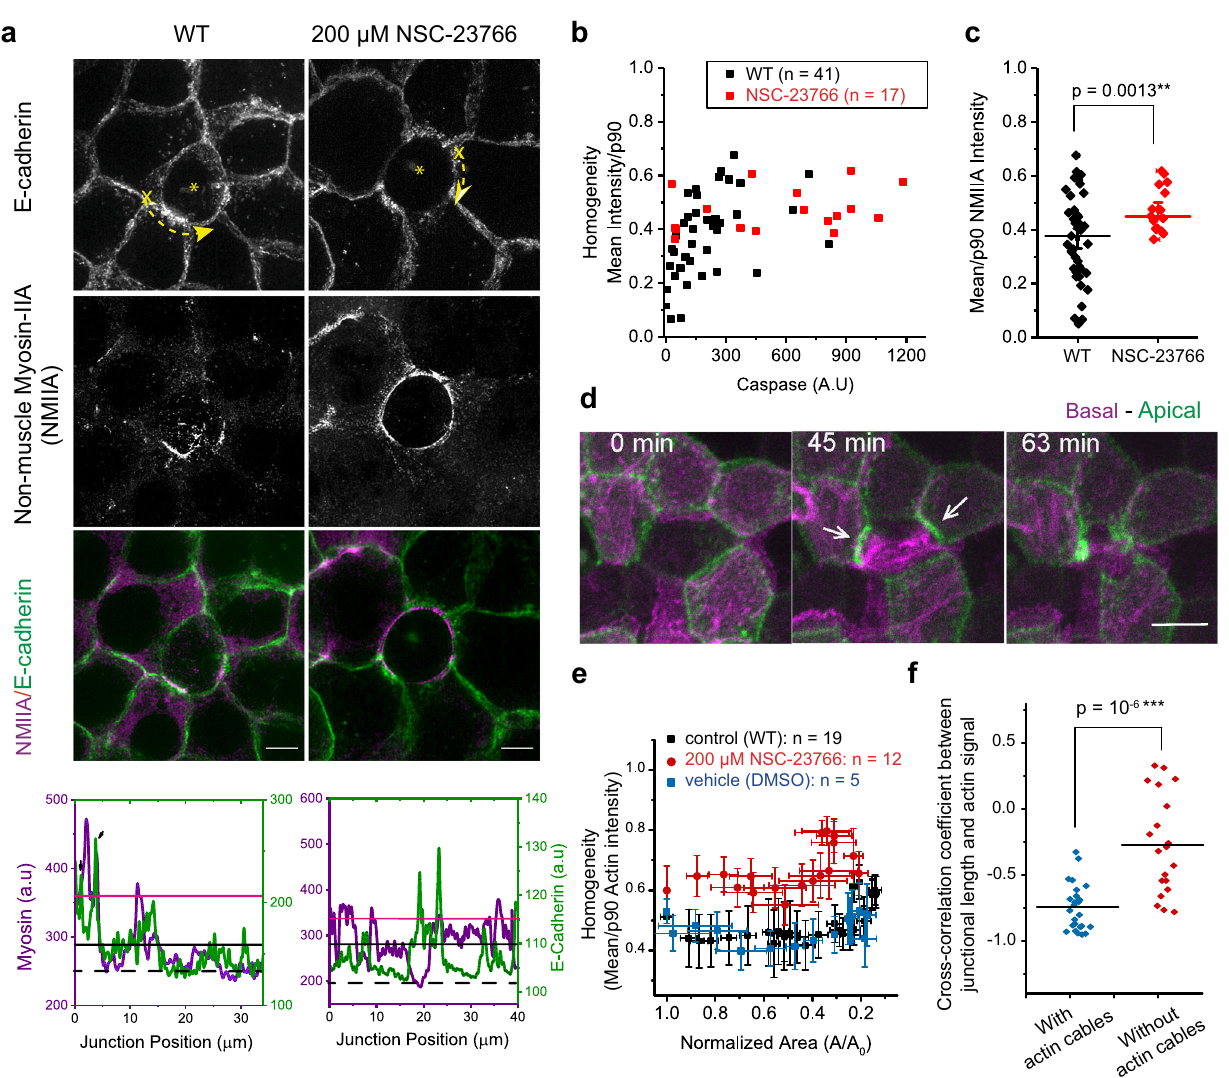
Fig. 2 Inhomogeneous actomyosin cables were observed and persistent during extrusion. a Immunostaining of non-muscle myosin-IIA (NMIIA) of extruding cells (asterisks) in MDCK stably expressing GFP-E-cadherin (WT) monolayer versus Rac-inhibited monolayer. Images show maximal projection of z-stack from 2 – 6 µ m above basal plane of SIM images. Scale bar = 10 µ m. Bottom panel: line scan of 10-pixel width showing intensity pro fi le along the junction between neighboring cells-extruding cell. Position 0 is indicated by X in the fi rst panel. Dashed arrows indicate the direction the line scan was performed. b Relationship between NMIIA intensity inhomogeneity and fl uorescence of caspase indicator. (Number of extrusion events: n = 41 for WT and n = 17 for Rac-inhibitor treatment. Number of independent experiments: m = 4 for WT and m = 2 for Rac-inhibitor treatment). Values closer to 1 indicate more homogeneous cables and closer to 0 indicates more nonuniform cables. c Inhomogeneity of actomyosin cables between WT versus Rac-inhibited monolayers by mean/p90 (normalized against the background intensity). Middle lines: mean. Error bars: SEM. Two-tailed unpaired t -test was performed. d Confocal time-lapse evolution of MDCK cell stably expressing Lifeact Ruby for actin undergoing extrusion. Basal plane (magenta) is superimposed with apical plane (green, 3.5 μ m above the basal plane). Scale bar = 10 µ m. T = 0 is de fi ned as the time point right after laser induction. e Average inhomogeneity of actin cable (indicated by actin signals in live imaging) as a function of area normalized against value at time 0. Values close to 1 indicate more inhomogeneous actin cables and values close to 0 indicate more inhomogeneous actin cables. Error bars: SEM. Number of independent experiments: WT: m = 3; Rac-inhibitor (NSC-23766): m = 2; DMSO (drug control): m = 1. f Cross-correlation analysis between junctional length and average junctional intensity on individual junctions. ( n = 26 for edges with cables and n = 20 for edges without cables in seven extrusions, three independent experiments). Middle lines: mean. Unpaired t -test (two-tailed) was performed. See more on Supplementary Fig. 5b. Source data in a – f are provided as a Source Data fi